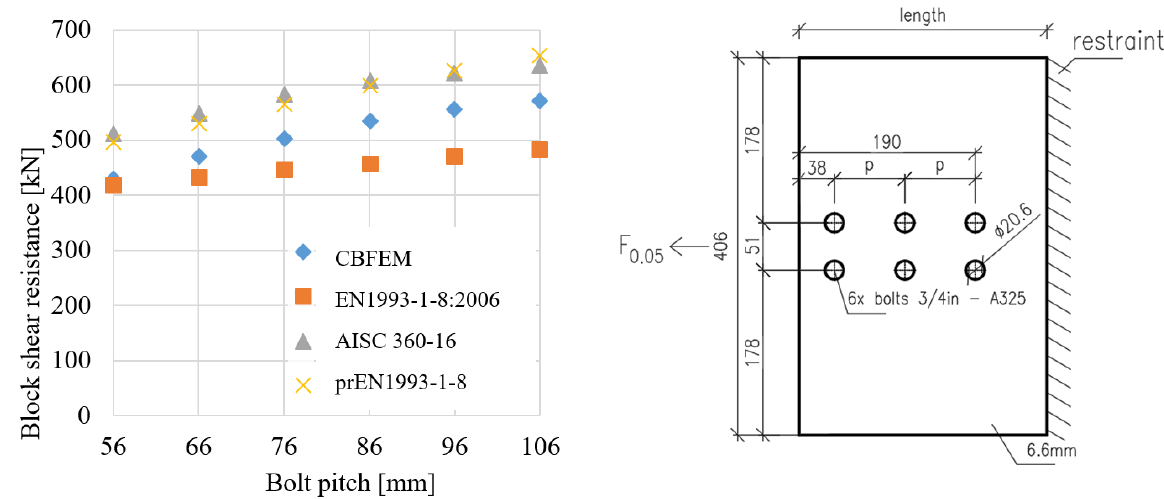
Figure 16. Sensitivity study of block shear resistance for bolt pitch, dimensions in mm.